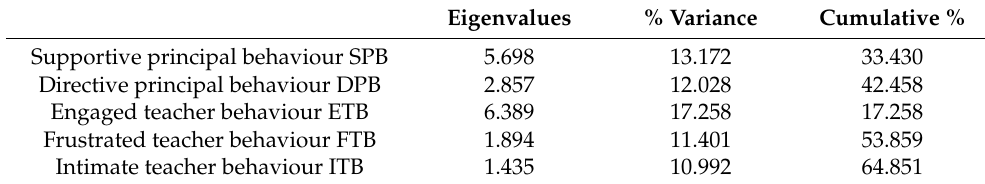
Table 1. OCDQ-RS dimensions—extracted factors.